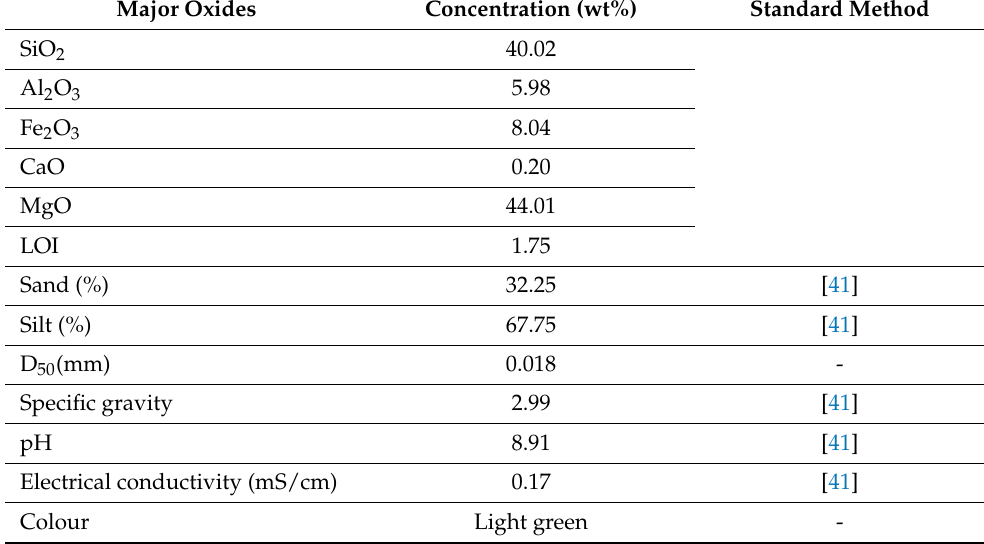
Table 2. The olivine physico-chemical